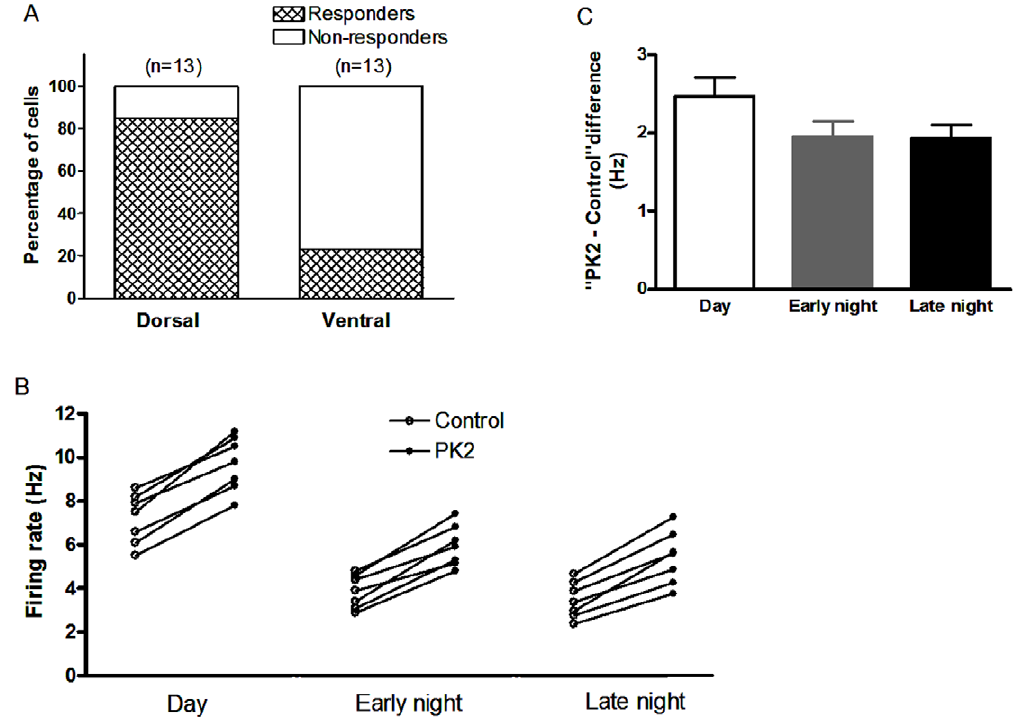
Figure 2. Effects of PK2 on spontaneous firing in different the SCN sub-regions and different the phases. (A) A majority of neurons (11/ 13) responded to 0.1 nM PK2 with increased firing rate in the dorsal division of SCN, in contrast, only three of 13 cells sensitive to PK2 in the ventral division. Cells that demonstrated at least a 10% the change in the firing rate were considered ‘‘responders’’. (B) PK2 (30 pM) increased firing rate of SCN neurons during three phases, day (ZT 4–8), early night (ZT 13–15), and late night (ZT 20–22). Each pair represents the firing rate of a neuron before and after PK2 treatment. (C) The histogram showing the ‘‘PK2 - Control’’ differences for firing rate during three phases in (B). There was no difference between the day, early and late night (n=7, P . 0.05, analysis of